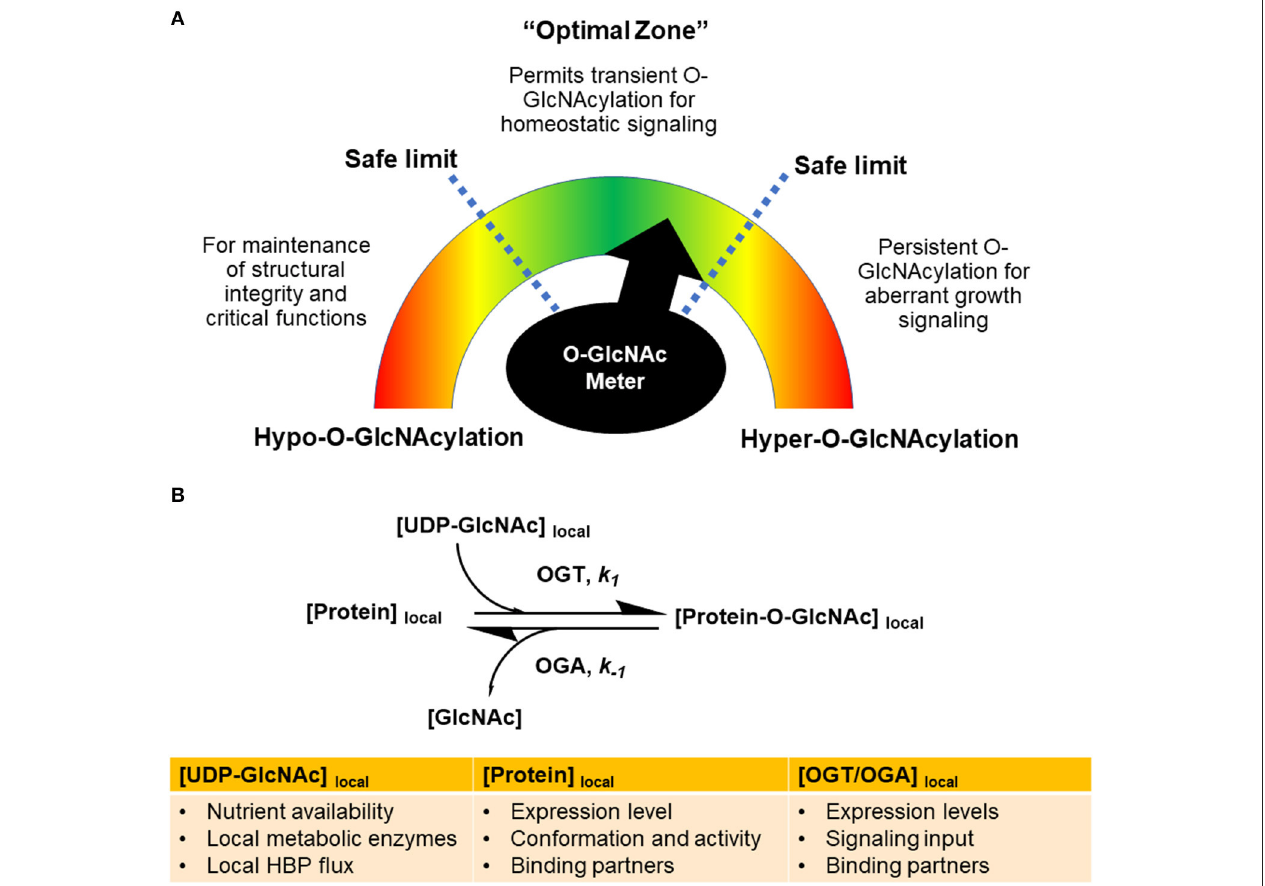
FIGURE 2 | Global and local levels of O-GlcNAcylation gauge signaling responses. (A) Global O-GlcNAcylation levels have to be maintained within an optimal range as depicted by an “O-GlcNAc meter” in analogy to a speedometer. Hyper-O-GlcNAcylation, as a result of hyper-OGT activity or high UDP-GlcNAc levels, would result in persistent O-GlcNAcylation of growth signaling proteins, leading to human diseases such as cancer. Hypo-O-GlcNAcylation would impair the structural integrity of protein substrates and their relevant functions. (B) The rates of O-GlcNAcylation and de-O-GlcNAcylation of specific proteins, denoted by k 1 and k − 1 , are tuned by the local microenvironment. The reactions are determined by local concentrations of UDP-GlcNAc, protein substrates, binding partners, and OGT/OGA activity. Signaling inputs converging on posttranslational modifications of OGT and OGA dictate k 1 and k − 1 of specific